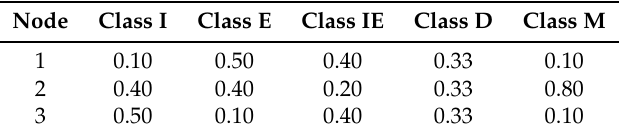
Table 1. Node heat capacity distribution for the the 3-node building elements roof rf and external walls ew . Class I: concentrated on interior side; Class E: concentrated on exterior side; Class IE: divided on interior and exterior side; Class D: equally distributed; Class M: inside/centered. Node Class I Class E Class IE Class D Class M 1 0.10